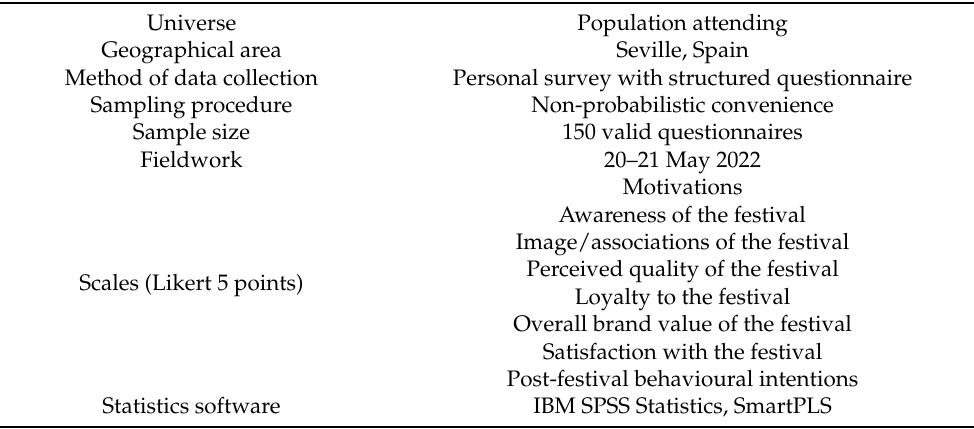
Table 1. Technical specifications of the research.